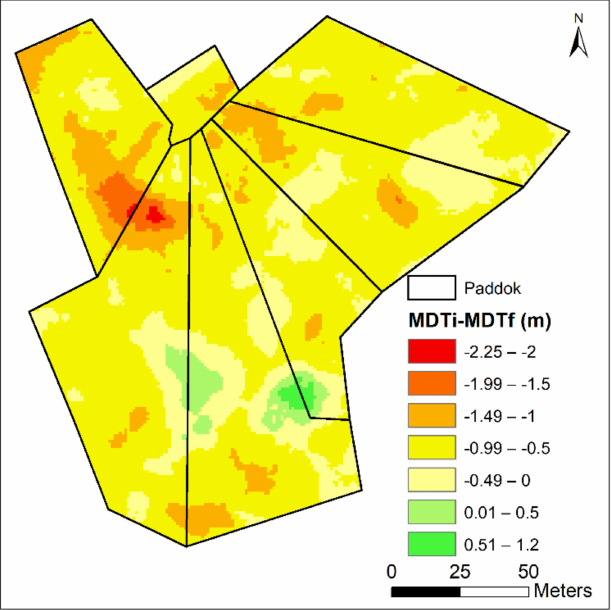
Figure 3. Soil erosion (t ha − 1 y − 1 ), ( a ) prediction by the RUSLE model and ( b ) observed soil erosion and sedimentation.